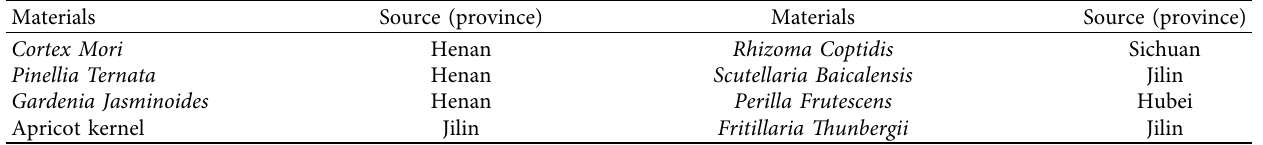
Table 1: Sources of the materials of SD.